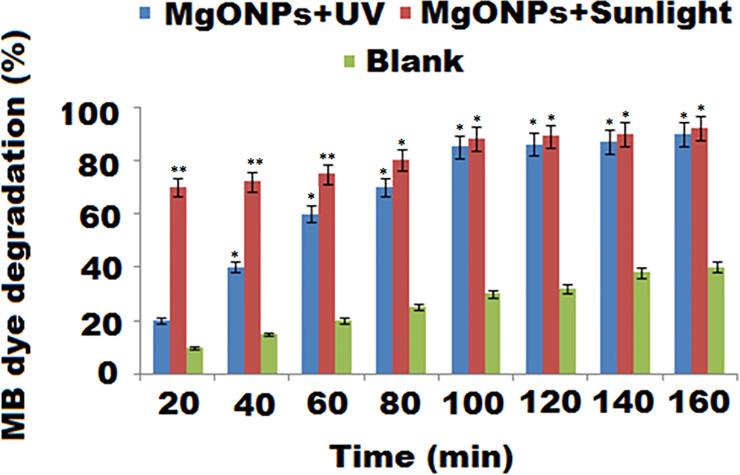
Catalytic effect of MgONPs calculated as % of MB dye degradation in the presence of UV radiation and sunlight.